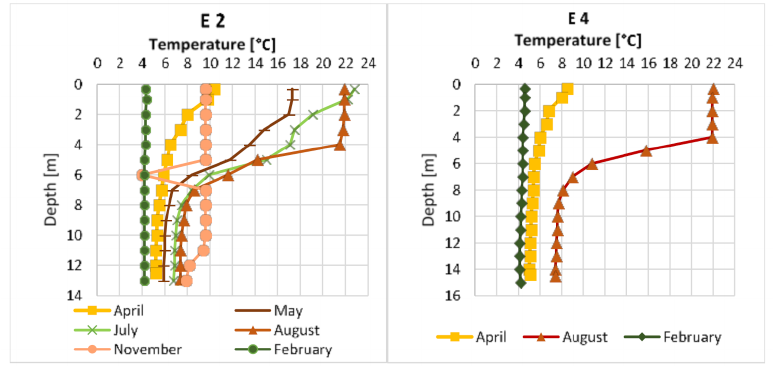
Figure 3. Temperature distribution in the water column of Lake Eichbaumsee at locations E2 and E4 between April 2018 and February 2019.